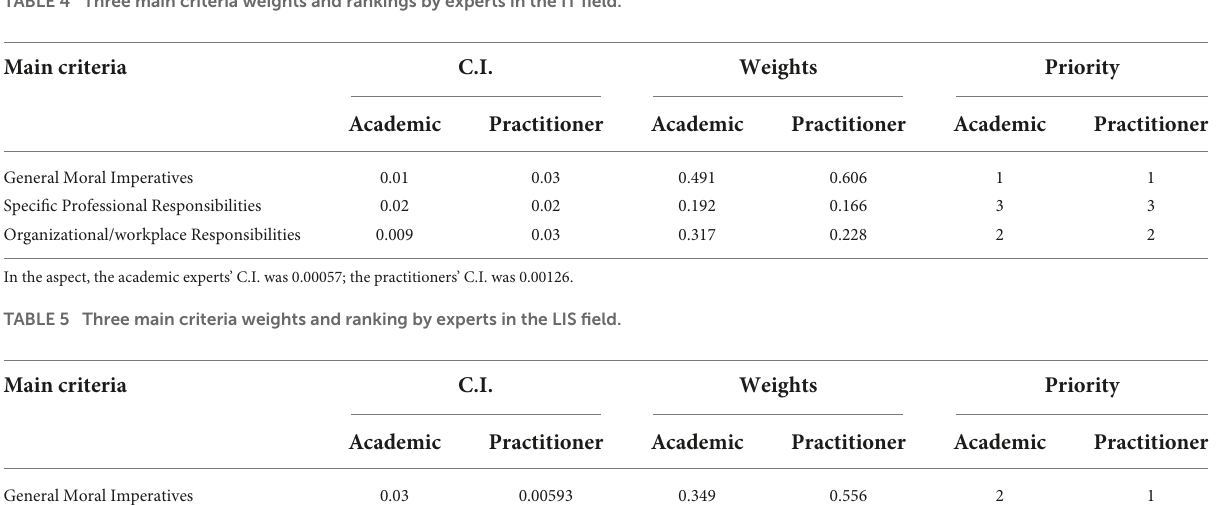
TABLE 4 Three main criteria weights and rankings by experts in the IT field.